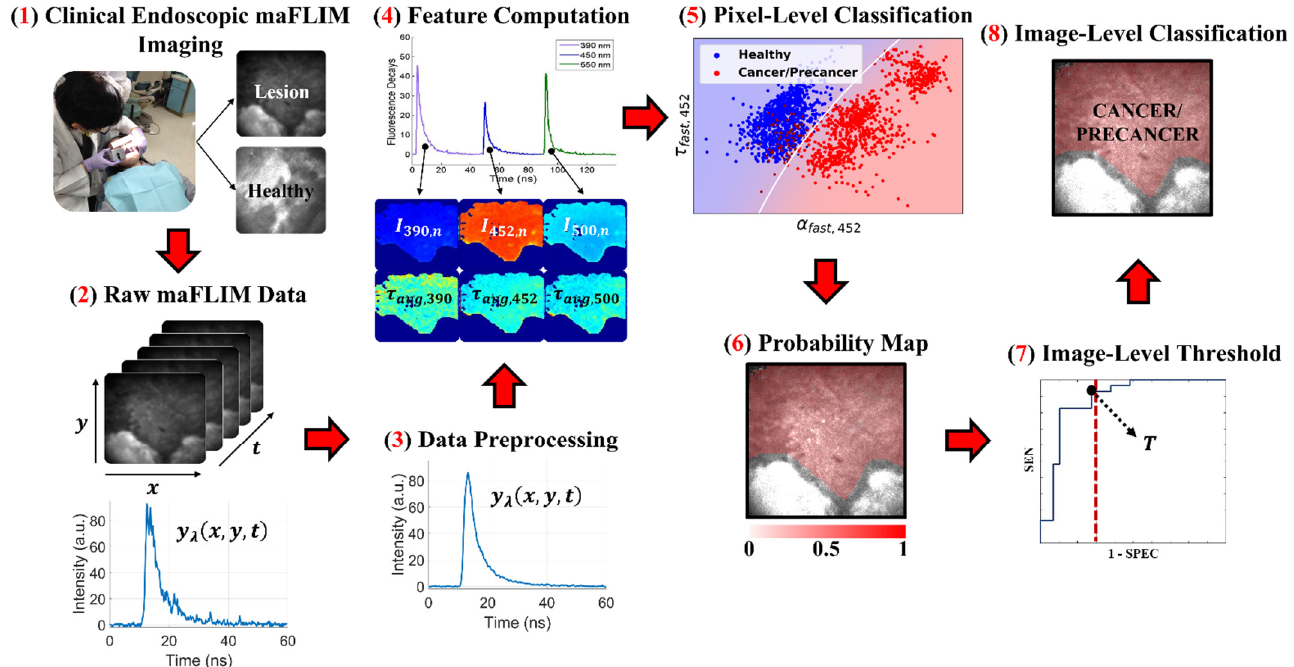
Figure 1. Summary of the methods used in this study. ( 1 ) In vivo clinical maFLIM images of both the lesions and healthy tissue regions from oral cancer patients were acquired. ( 2 , 3 ) Raw maFLIM data were preprocessed to increase the signal quality. ( 4 ) Autofluorescence spectral and time-resolved maFLIM features were computed per pixel. ( 5 ) Models for the classification of precancer/cancer vs. healthy oral tissue at the pixel level were trained. ( 6 ) Pixel-level classification results in a posterior probability map for each imaged oral tissue region. ( 7 ) An image-level score was computed from the posterior probability map, and a threshold (T) on this score was optimized. ( 8 ) The image-level score threshold was applied to classify the whole image as either precancer/cancer or healthy. Note. Modified from “Clinical label-free biochemical and metabolic fluorescence lifetime endoscopic imaging of precancerous and cancerous oral lesions,” by Duran-Sierra, E.; Cheng, S.; Cuenca-Martinez, R.; Malik, B.; Maitland, K.C.; Lisa Cheng, Y.S.; Wright, J.; Ahmed, B.; Ji, J.; Martinez, M.; et al . , 2020, Oral Oncol , p. 2, doi:10.1016/j.oraloncology.2020.104635 [20].